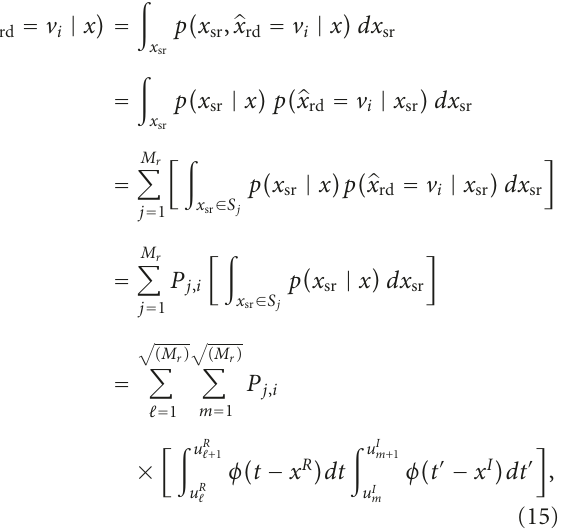
(see Section 3.1) where we have defined P R of complex representatives. We